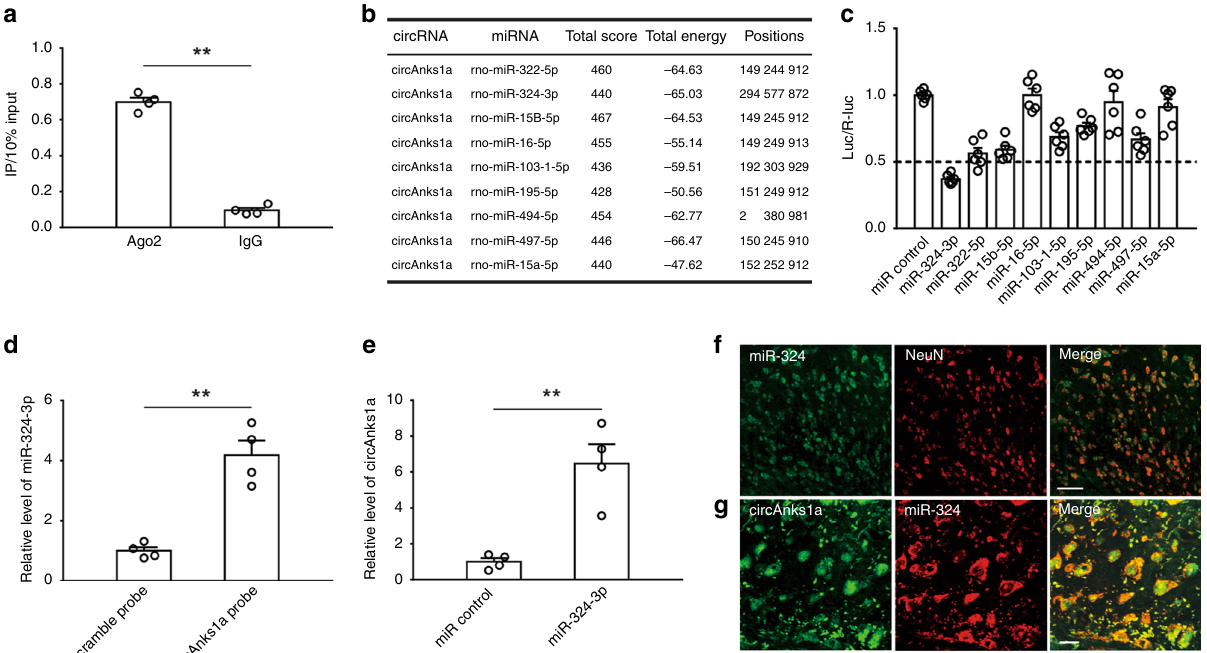
Fig. 9 CircAnks1a interacted with miR-324-3p. a RIP showed that circAnks1a was enriched in AGO2 immunoprecipitates ( ** P < 0.01 vs. IgG group, two- tailed two-sample t tests, n = 4). b 9 miRNAs had at least 3 potential sites in circAnks1a by in silico analysis. c A luciferase reporter assay for the luciferase activity of Luc-circAnks1a in 293T cells transfected with different miRNA mimics was used to identify miRNAs that bound to the circAnks1a sequence ( n = 6). d Compared with the scramble probe, the level of miR-324-3p pulled-down by the circAnks1a probe was obviously higher ( ** P < 0.01 vs. scramble group, two-tailed two-sample t tests, n = 4). e MiR-324-3p probe was used to examine the interaction between miR-324-3p and circAnks1a in dorsal horn tissues ( ** P < 0.01 vs. miR control group, two-tailed two-sample t tests, n = 4). f , g FISH showed that miR-324-3p was expressed in neurons and that it colocalized with circAnks1a-positive cells. Scale bars, 50 and 10 μ m, respectively ( n = 3). The data are presented as the mean ± s.e.m. Source data